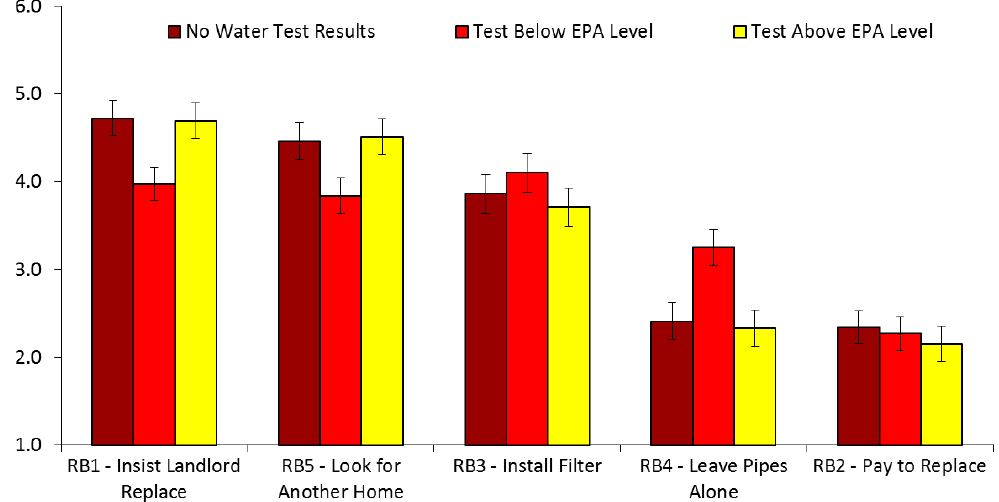
Figure 2. Willingness to adopt risk mitigation behaviors, by landlord/renter condition. Error bars indicate 95% confidence intervals with Bonferroni corrections.